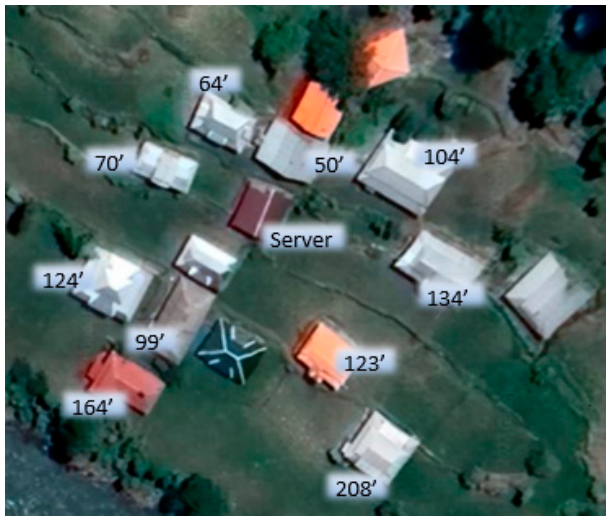
Figure 7. The distance between houses and the Wi ‐ Fi server